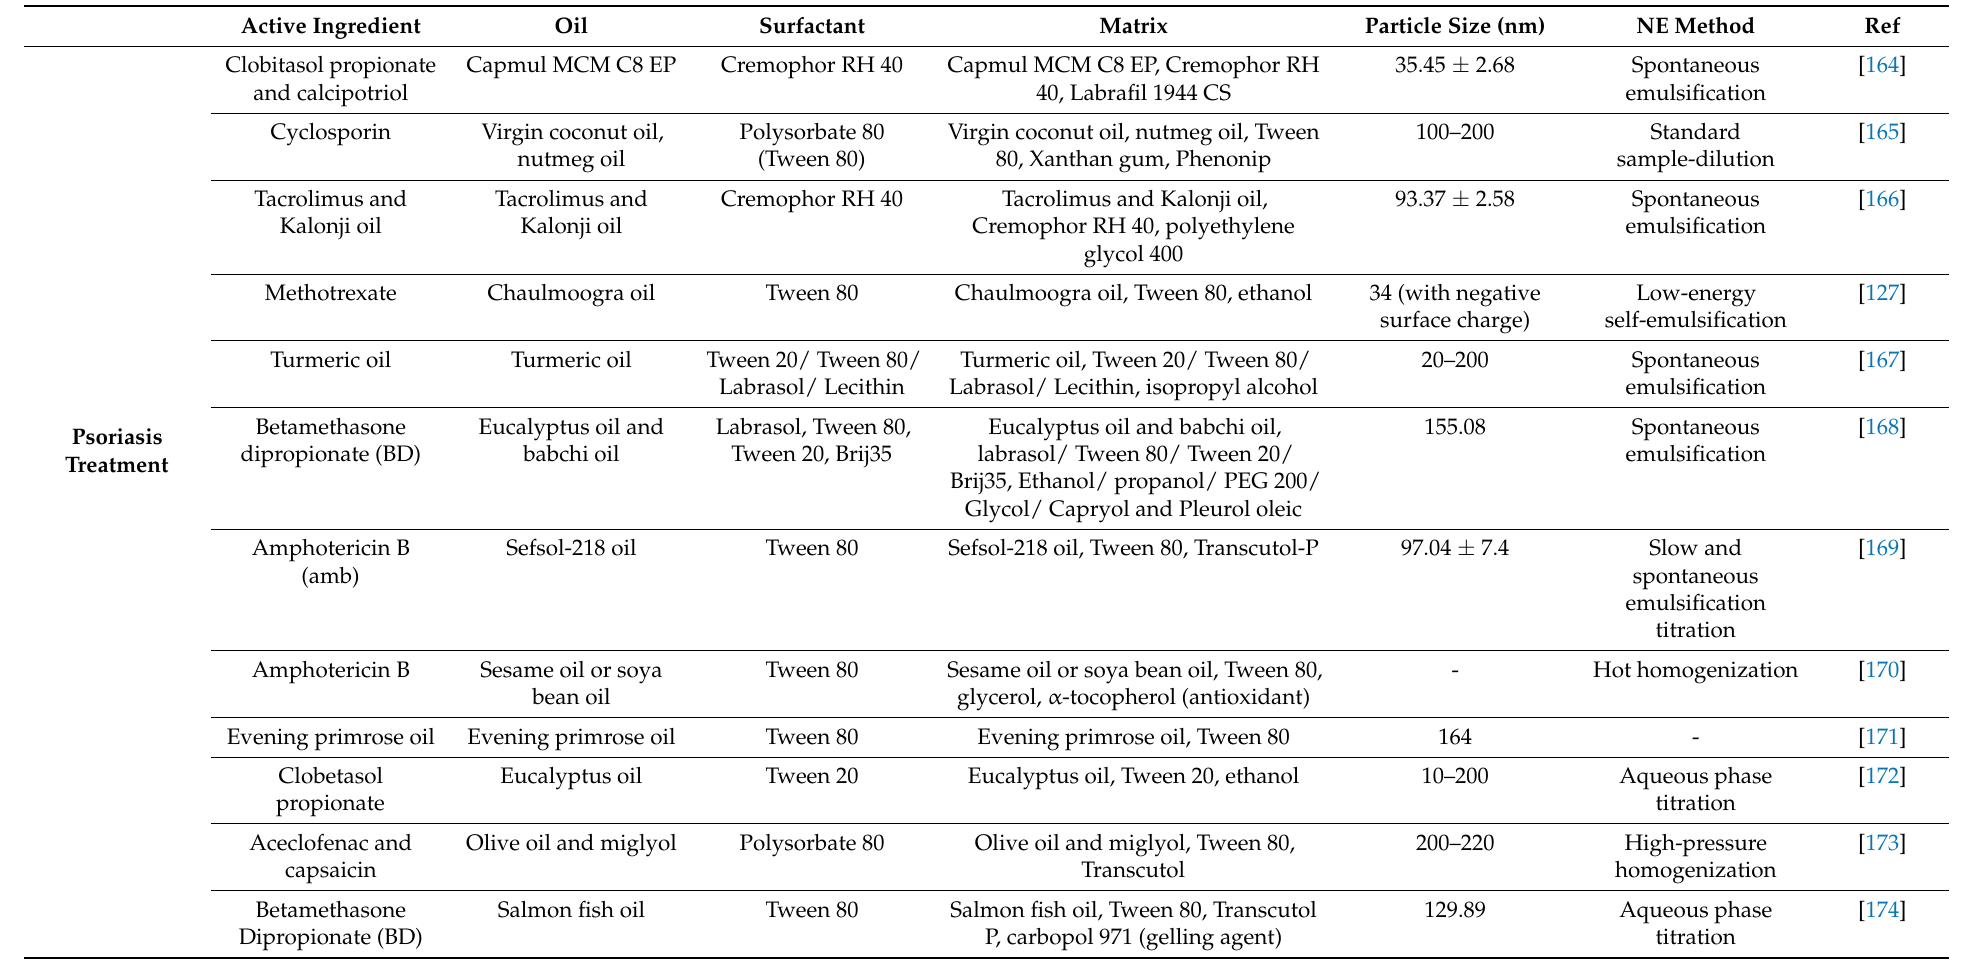
Table 5. List of recent studies on low-energy nanoemulsification for psoriatic treatment and other